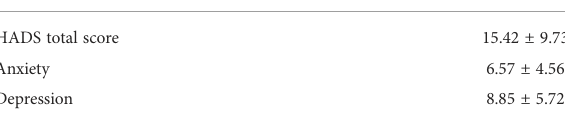
TABLE 7 Hospital Anxiety and Depression Scale in lung cancer patients with chemotherapy (N = 302).